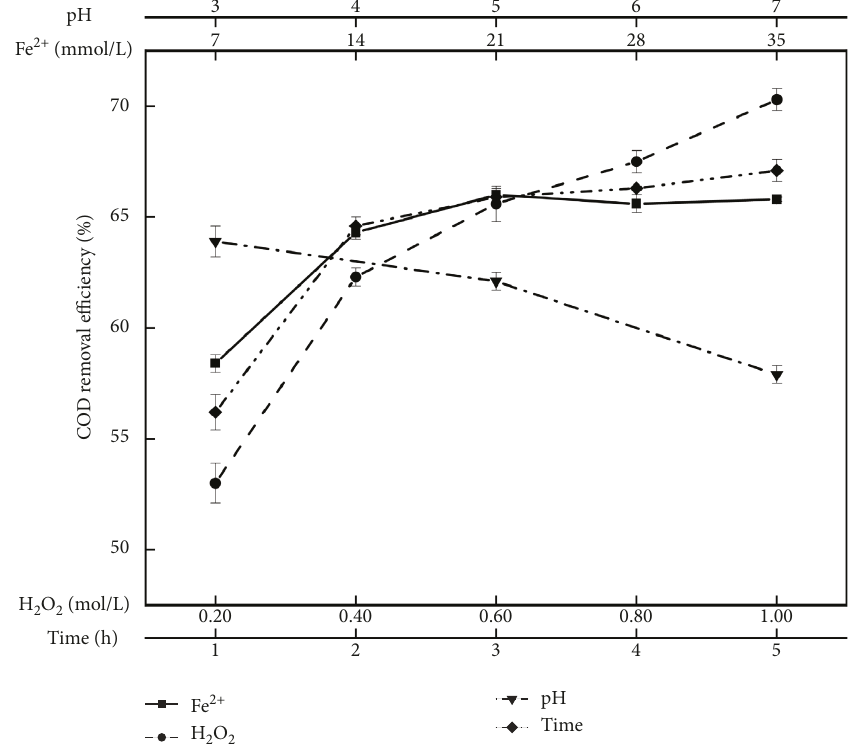
Figure 2: Relationship between COD removal efficiency and H